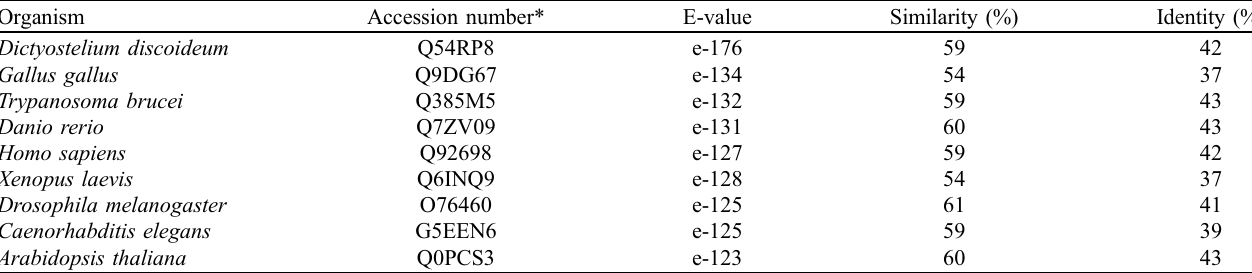
Table 1. Comparison of predicted EhRAD54 with homologous proteins in other